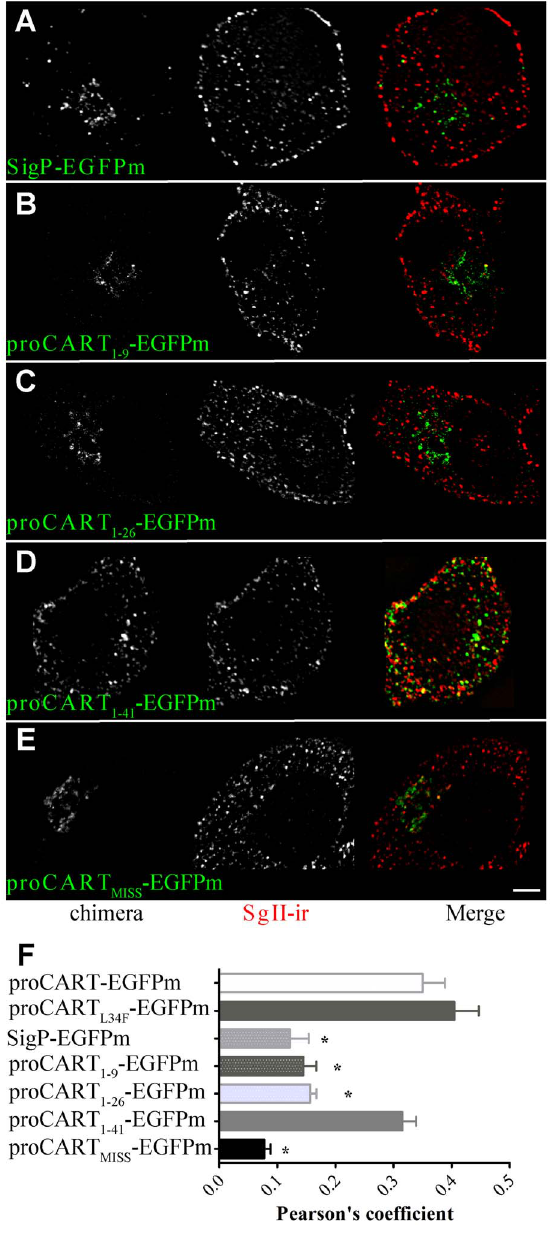
Figure 2. Subcellular distribution of CART-EGFPm fusion proteins. Confocal images of PC12 cells transfected with SigP-EGFPm (A), proCART 1–9 -EGFPm (B), proCART 1–26 -EGFPm (C), proCART 1–41 - EGFPm (D) or proCART MISS -EGFPm (E) expression vectors. Aldehyde- fixed cells were subjected to immunofluorescence protocols using SgII antibody. (A–E) Left panel: EGFPm signal. Middle: SgII-ir signal.